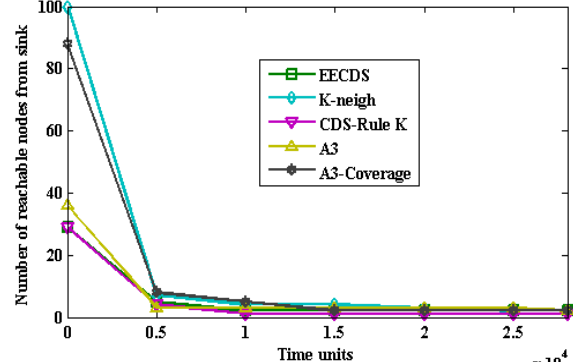
Figure 4. Network lifetime for number of reachable nodes from